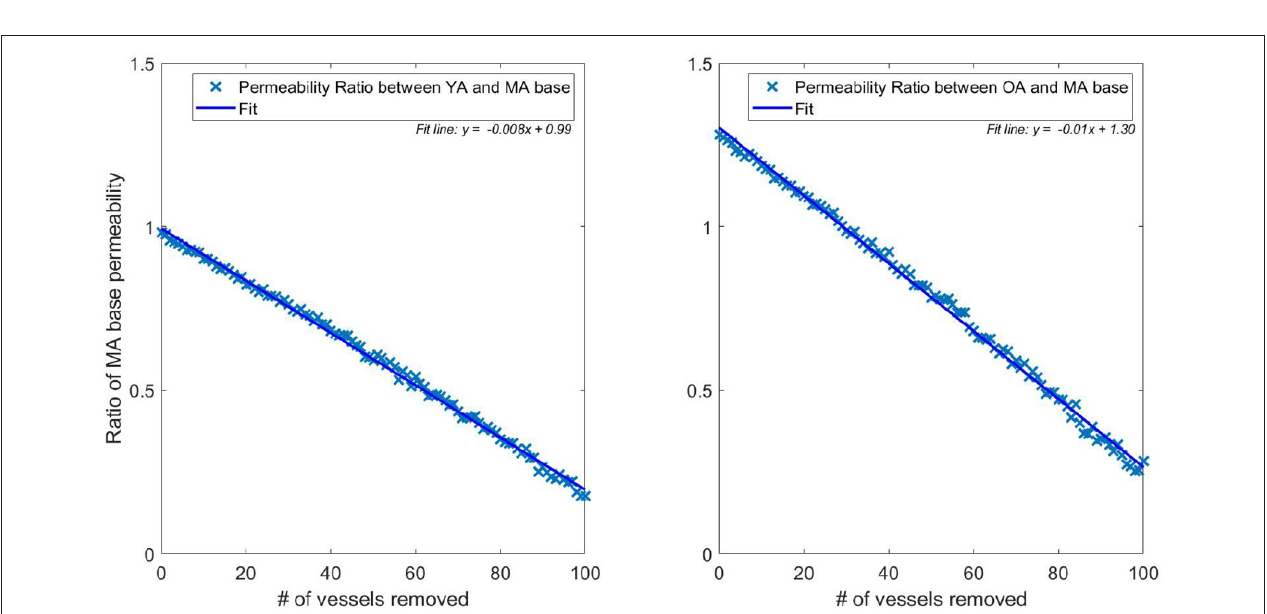
FIGURE 4 | Visualising the change in vessel parameters in a cubic volume of the ageing brain with a middle-age network (A) and old-age network (B) . Blue dashed lines indicate the vessels pruned to achieve an accurate old-age vessel density.